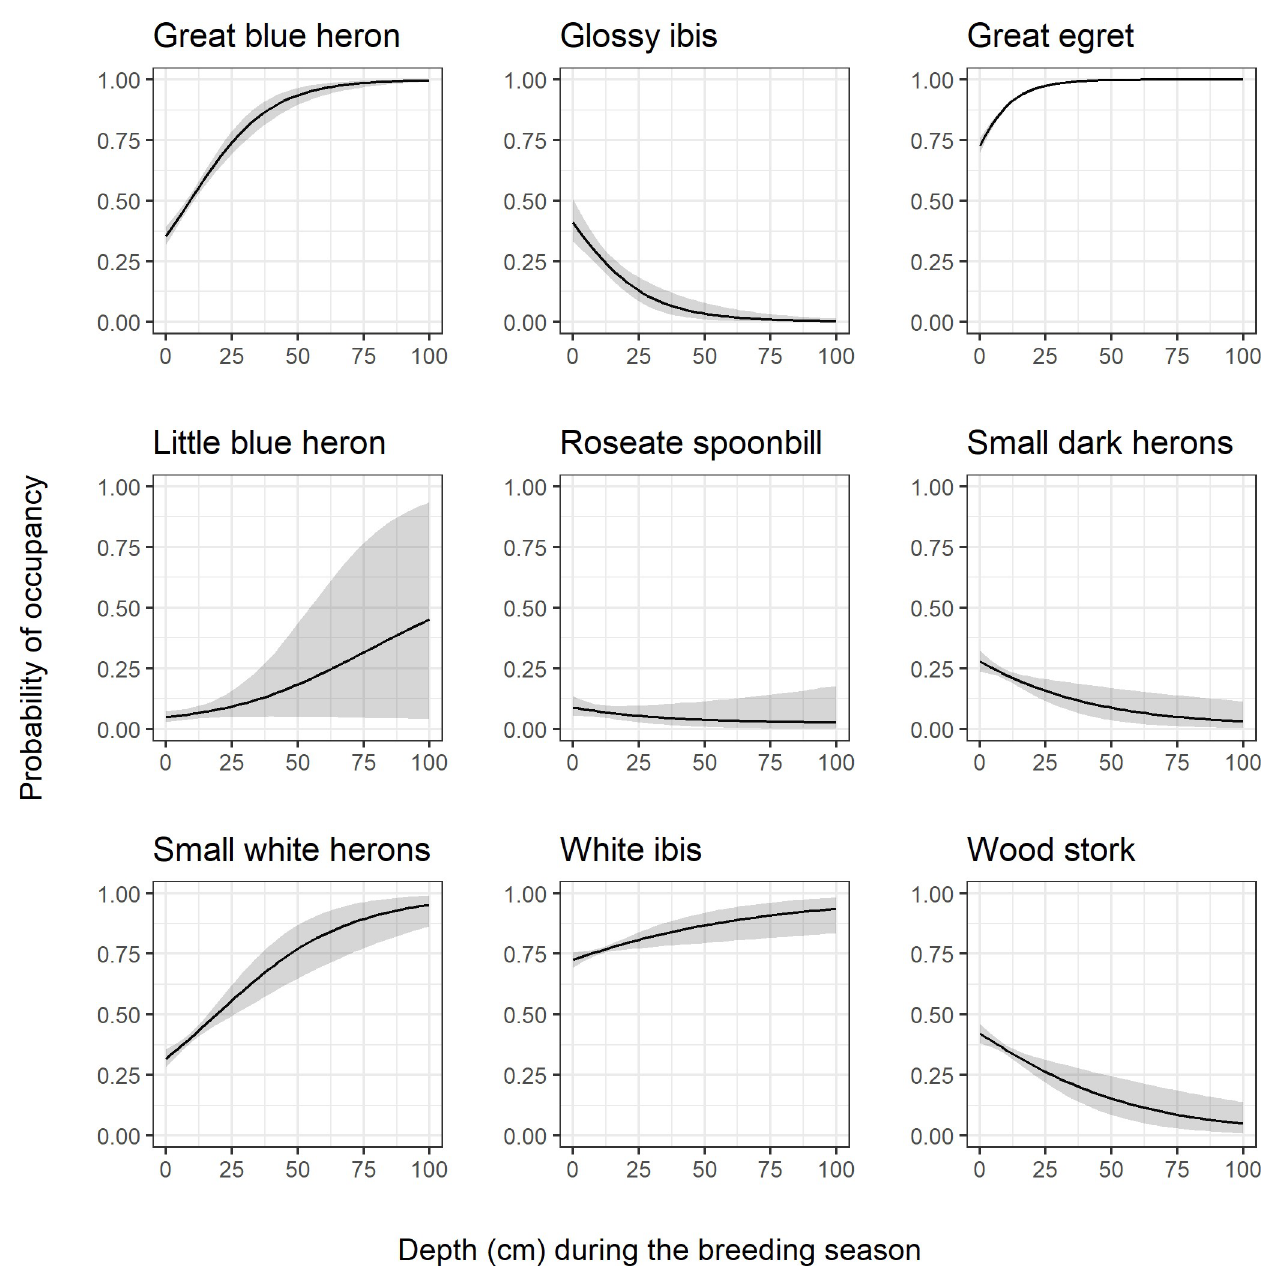
Fig 5. Breeding season depth response curves. Species-specific relationships between probability of occupancy and average depth during the breeding season (Jan 1 –June 30) from a fitted joint species distribution model of wading birds. Responses are calculated with all other model variables held at their mean. The black line represents the posterior mean and the gray shading represents the 95% posterior